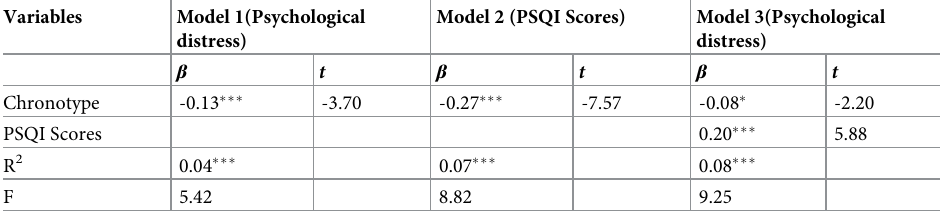
Table 3. Mediation analysis (n = 884).